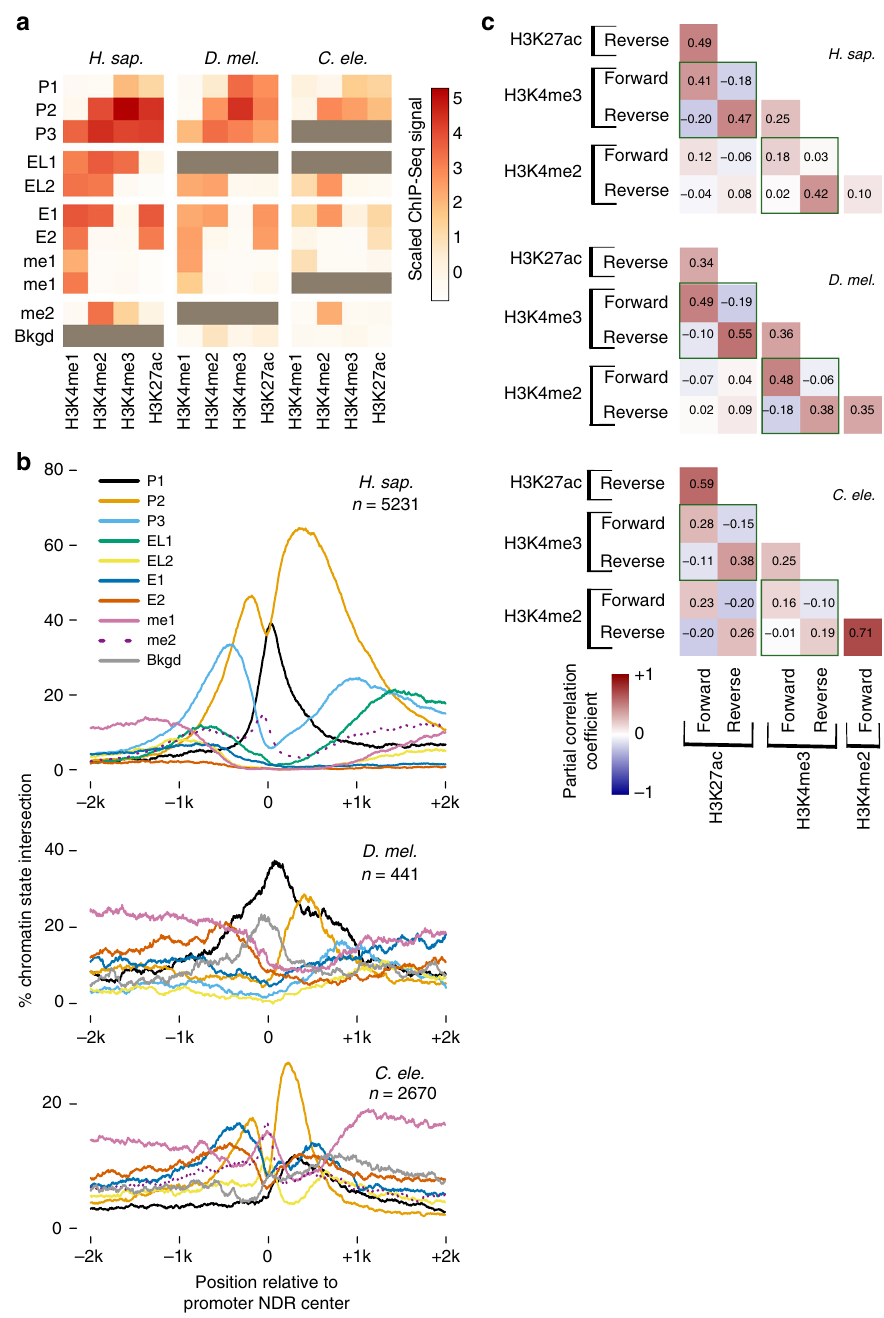
Fig. 3 Promoter histone PTM states are direction-speci fi c. a A heatmap representing chromatin states learned for each species via a multivariate Gaussian Hidden Markov Model. Each state is a multivariate Gaussian distribution and is represented here via the mean scaled ChIP-Seq signal. Gray boxes indicate the state was not detected in the respective organism. P1/2/3: Promoter1/2/3, EL1/2: Transcription elongation1/2, E1/2: Enhancer1/2, me1: H3K4me1, me2: H3K4me2, Bkgd: Background. b Chromatin state positional coverage for promoters with stringently selected forward and reverse TSSs. c Partial- Table 2 for full partial-correlation